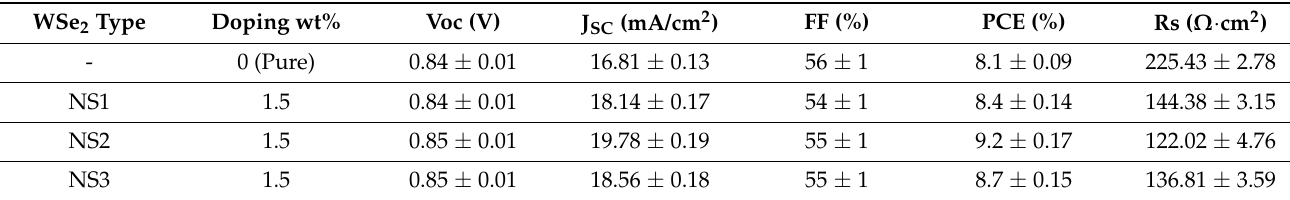
Table 1. PSC performances of pristine and different WSe 2 NSs blended PBDB-T:PCBM active layers using constructed devices ( ± indicates the standard deviation).